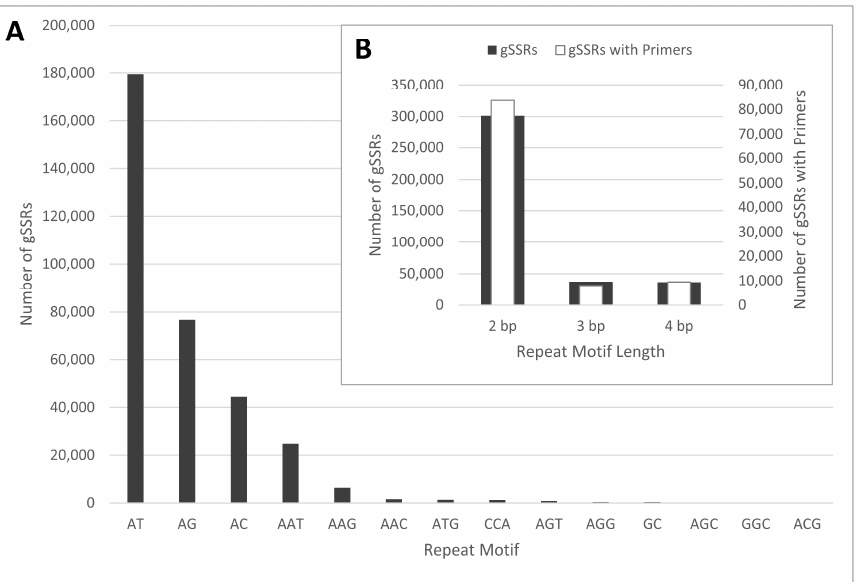
Figure 1. Genomic simple sequence repeats (gSSRs) discovered in the de novo assembled genome of Viburnum farreri ‘Nanum’. Overall number of gSSRs identified with our algorithm are in grey, based on repeat motif ( A ) and repeat motif length ( B ). Note specific repeat motif frequencies for tetra-nucleotide repeats were not calculated and therefore not included in ( A ). The number of gSSRs with primers designed for the locus based on repeat motif length are depicted in white and on the secondary axis ( B ). bp = base pairs.